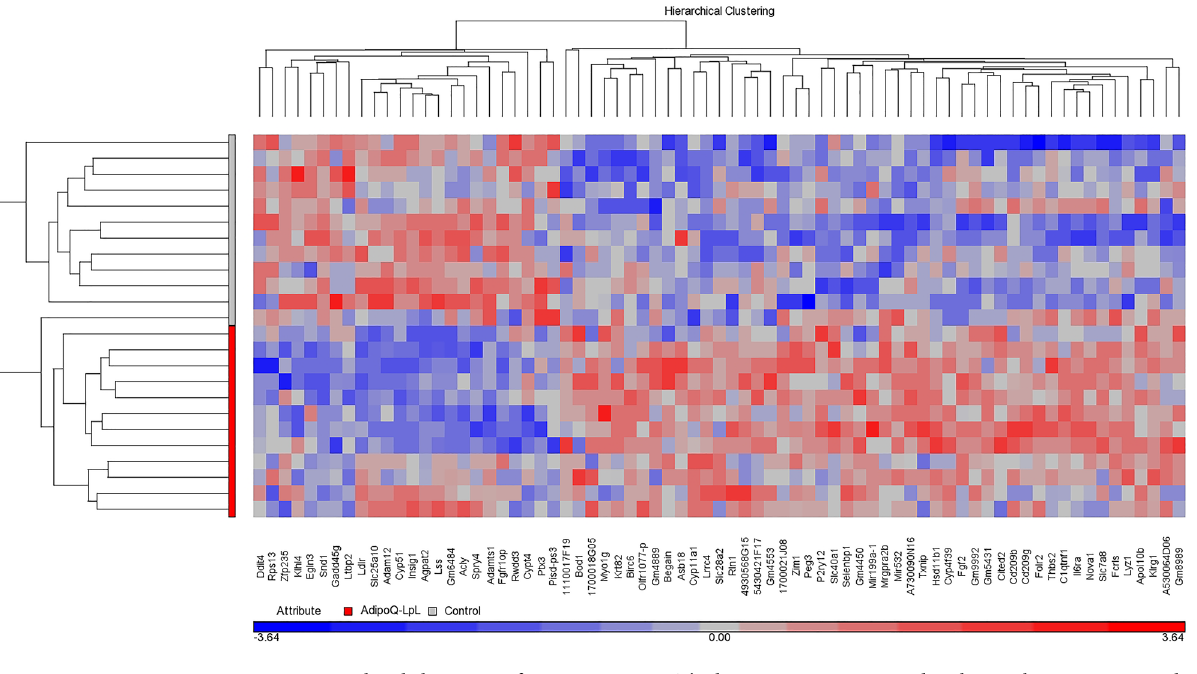
Figure 2. Hierarchical clustering of gene expression. The heat map was generated with Partek using genes with a P value less than 0.01 and a 1.25-fold change in